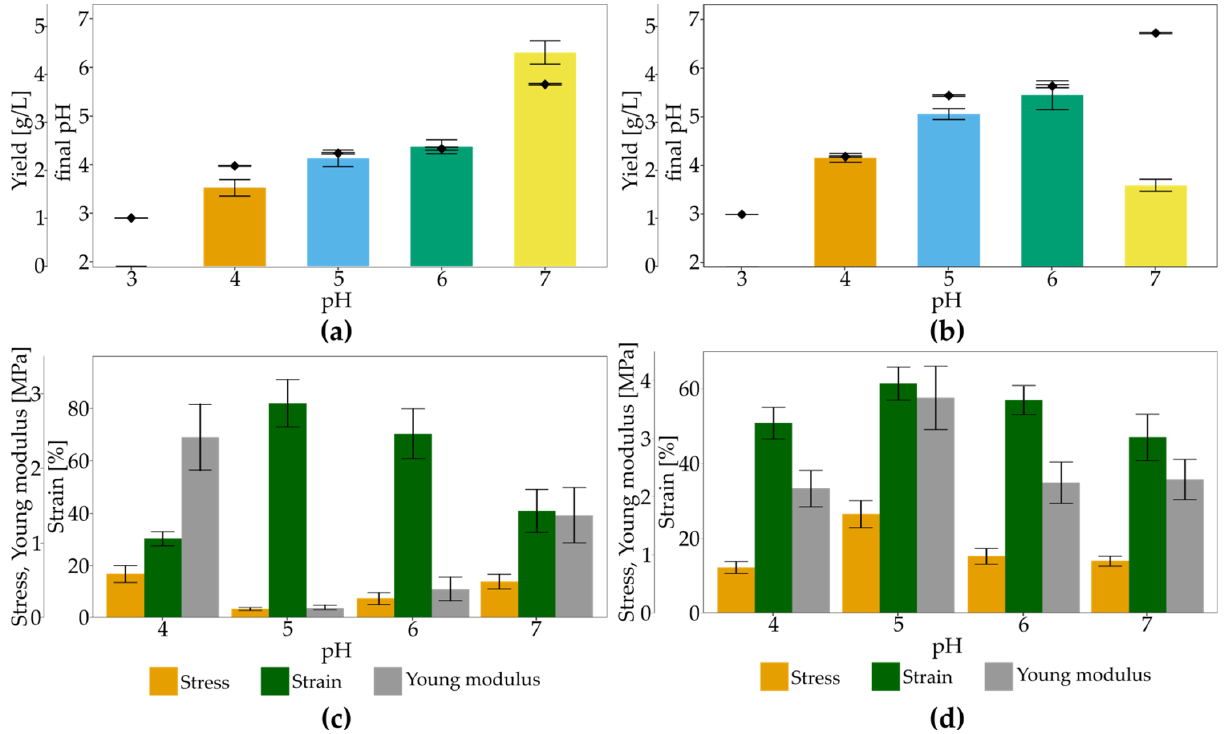
Figure 6. The yield (bars) of BNC and final pH (diamonds) in ( a ) SH medium and ( b ) SH medium modified glycerol at different initial pH, and mechanical properties of BNC membranes produced in ( c ) SH medium and ( d ) SH medium modified glycerol at different initial pH; error bars represent standard deviation.